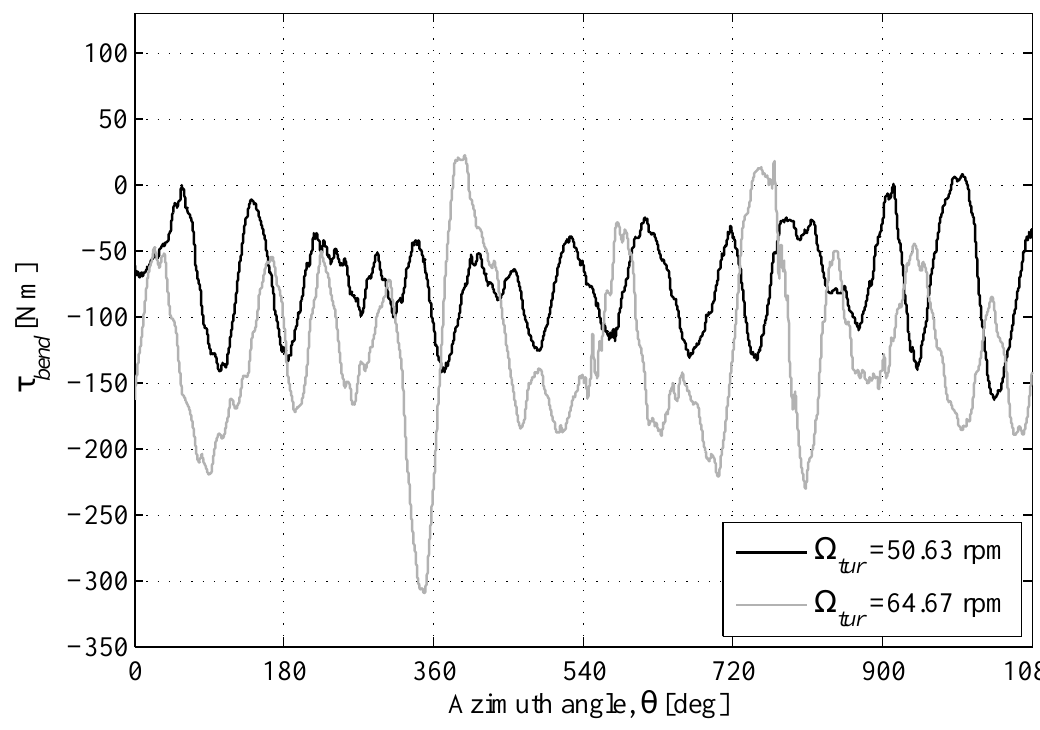
Figure 12. Comparison of the measured τ